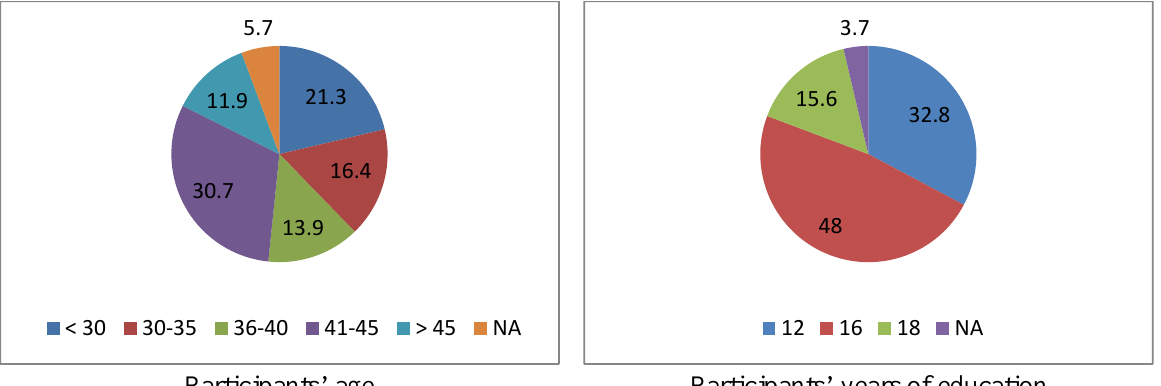
Fig. 1. Personal characteristics of the